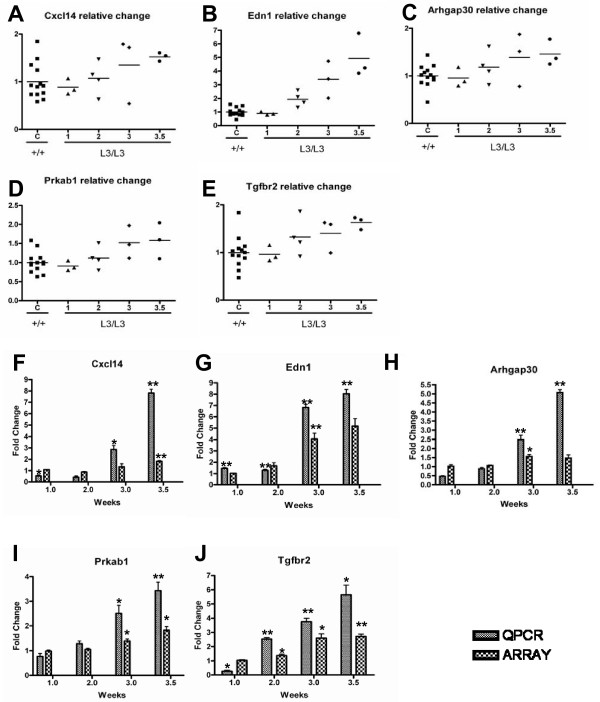
Selected genes which might be related to disease progression from correlation analysis and RT-PCR validation. Genes whose expression increased or decreased with disease progression were identified by correlation analysis of microarray data (A~E). Changes in transcript abundance are expressed as amount of change relative to control mean for that gene, and individual values of three different mice and the mean are shown at each week. (F~J) Validation of the microarray results by QRT-PCR analysis, showing relative change of PCR signal between wild-type and Pkd1L3/L3 mice (mean ± SD of triplicate PCR reactions of pooled RNA; n = 3; *, P < 0.05; **, P < 0.01 compared with wild-type mice, by Student's t-test).